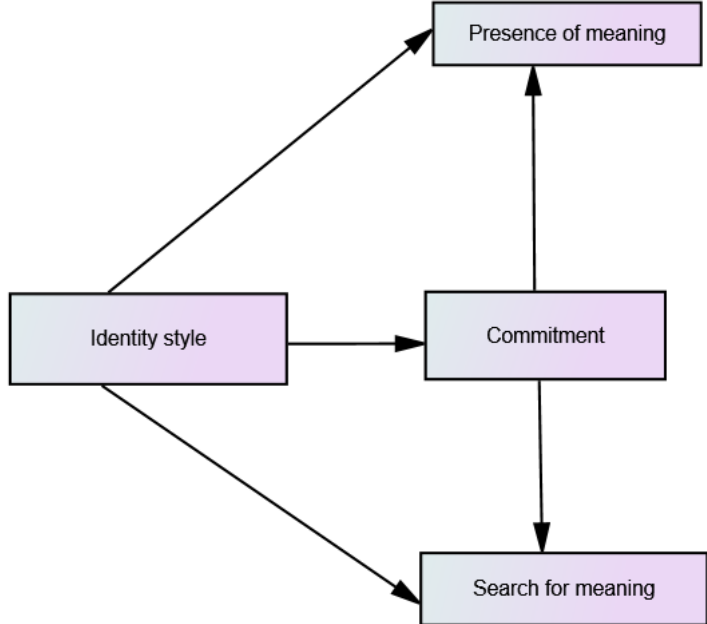
Figure 1. Hypothetical path model of the predictive relationships between identity style, commitment, presence of meaning and search for meaning in life.